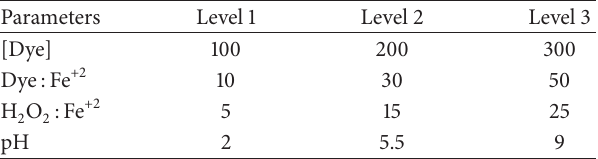
Table 6: Factors and levels of orthogonal